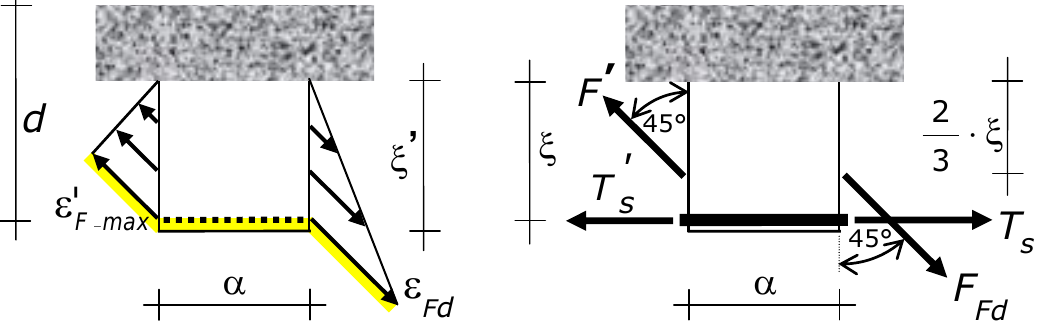
Figure 4. Concrete cantilever that fails (the midspan of the beam is on the right of the figure). On the left: strain profile in the external reinforcement at the two cracked sections that define the lateral sides (boundaries) of the concrete cantilever. The strain is linear, starting from zero at the neutral axis up to ε Fd at the right crack and up to ε (cid:48) Fd at the left crack. The external reinforcement bonded onto the concrete cover (which is shadowed) does not transmit any stress. On the right: forces transferred from the longitudinal steel bars (flexural reinforcement) and from the side-bonded reinforcement (the fibers are at 45 ◦ ) to the concrete cantilever. The latter forces consist in a resisting contribution that makes the effects of the former forces less.